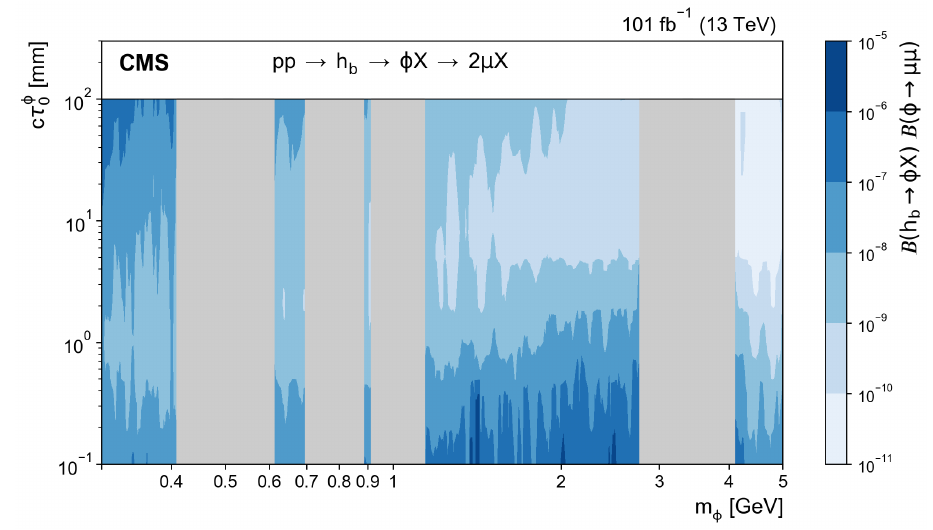
Figure 9 . Observed limits at 95% CL on the branching fraction product B ( h as contours in the parameter space containing the signal mass ( m vertical gray bands indicate mass ranges containing known SM resonances, which are masked for the purpose of this search. The limits are obtained using the combination of all dimuon event categories.